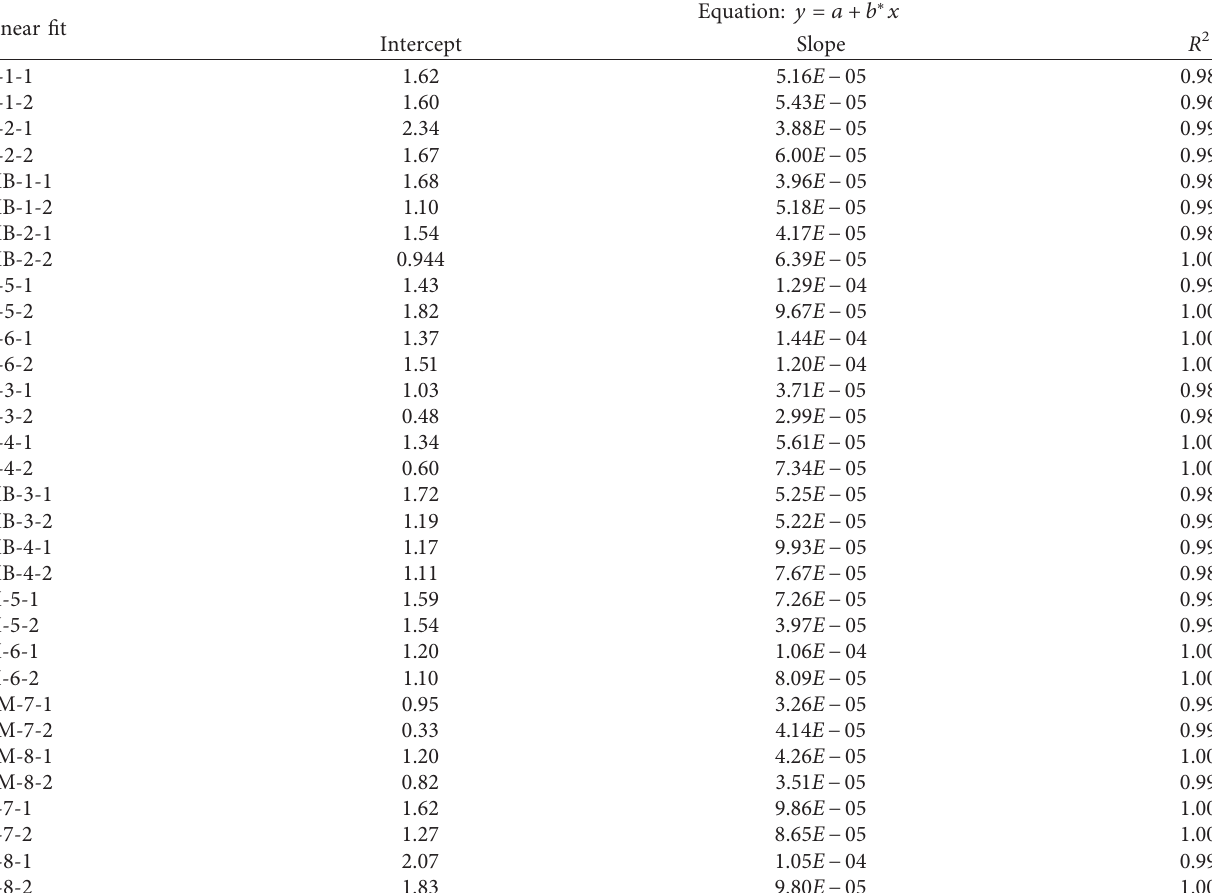
Table 5: Linear fit of rutting curves between 6000 and 20000 loading cycles.